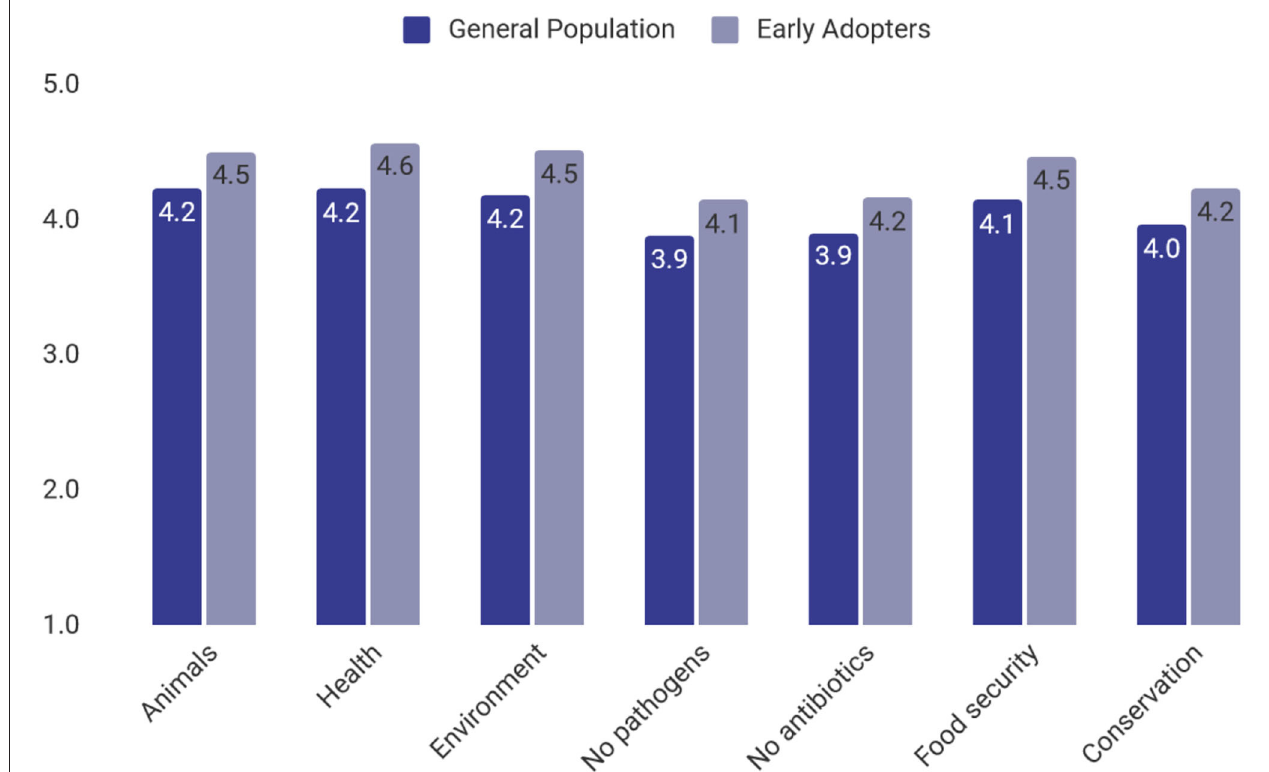
FIGURE 8 | Mean importance of motivations for plant-based meat in the general population and among early adopters.